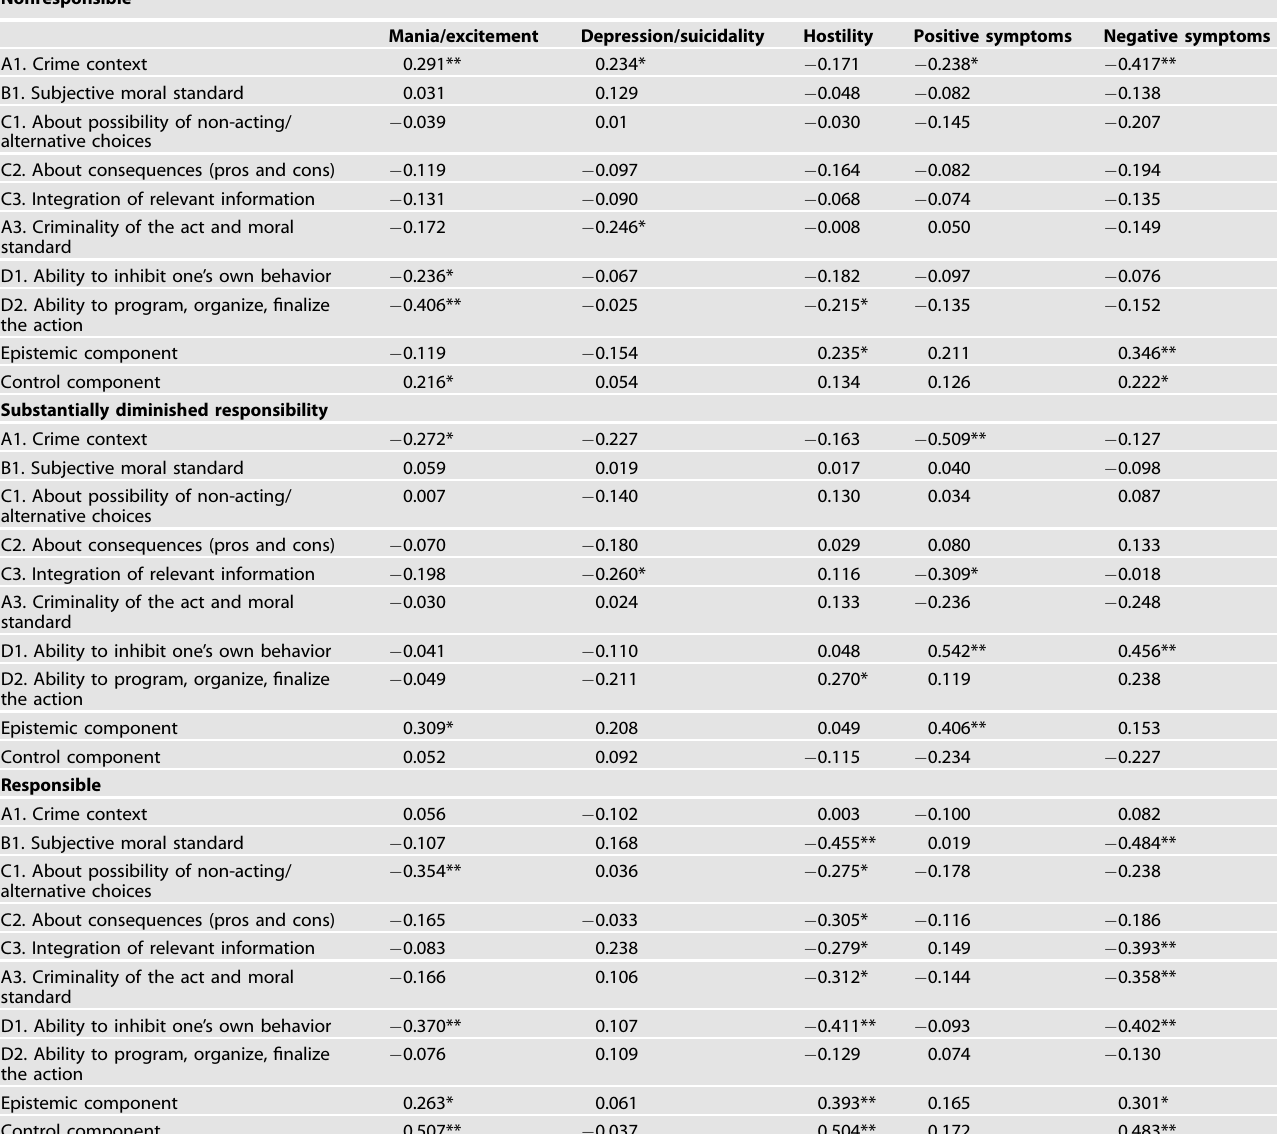
Table 6. Correlations between the items of the DIASS and psychopathological dimension in defendant judged nonresponsible, with substantially diminished responsibility and